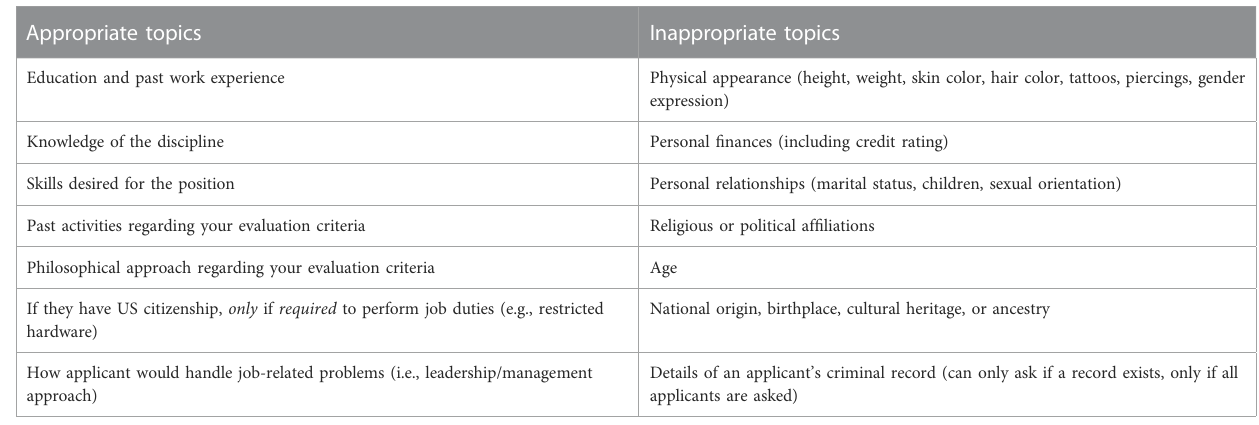
TABLE 3 Appropriate and inappropriate conversation topics with job